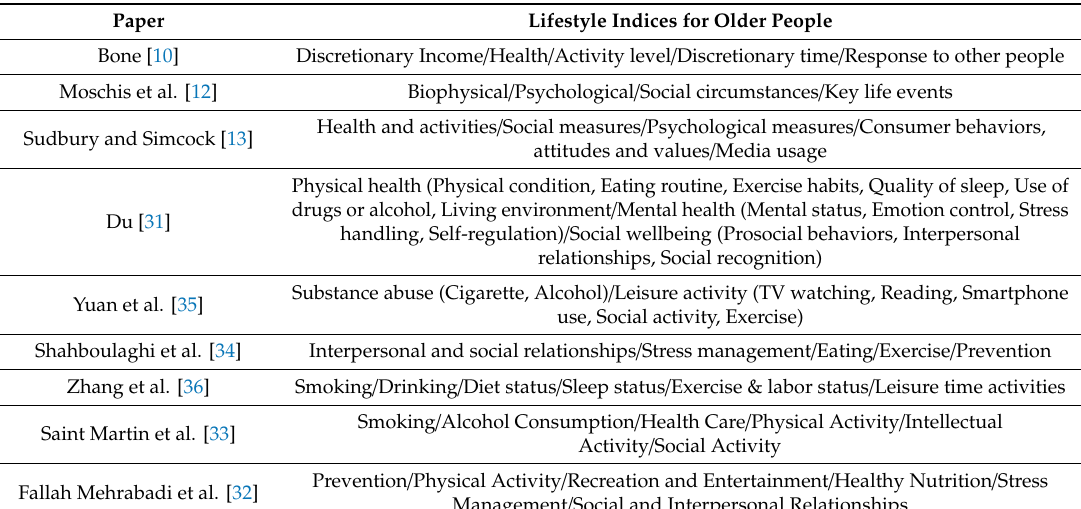
Table A1. Lifestyles of older